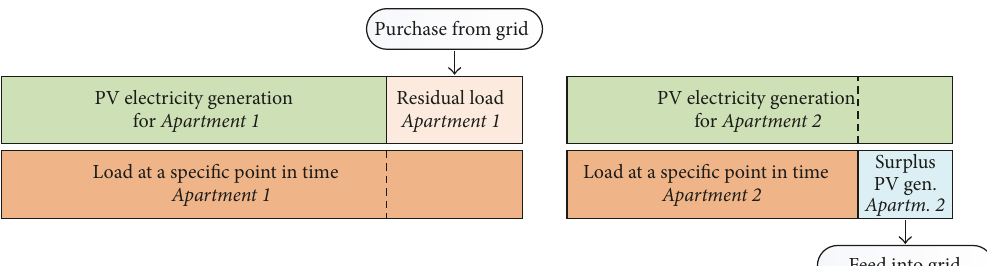
Figure 26: Static allocation of PV generation: example of two apartments.